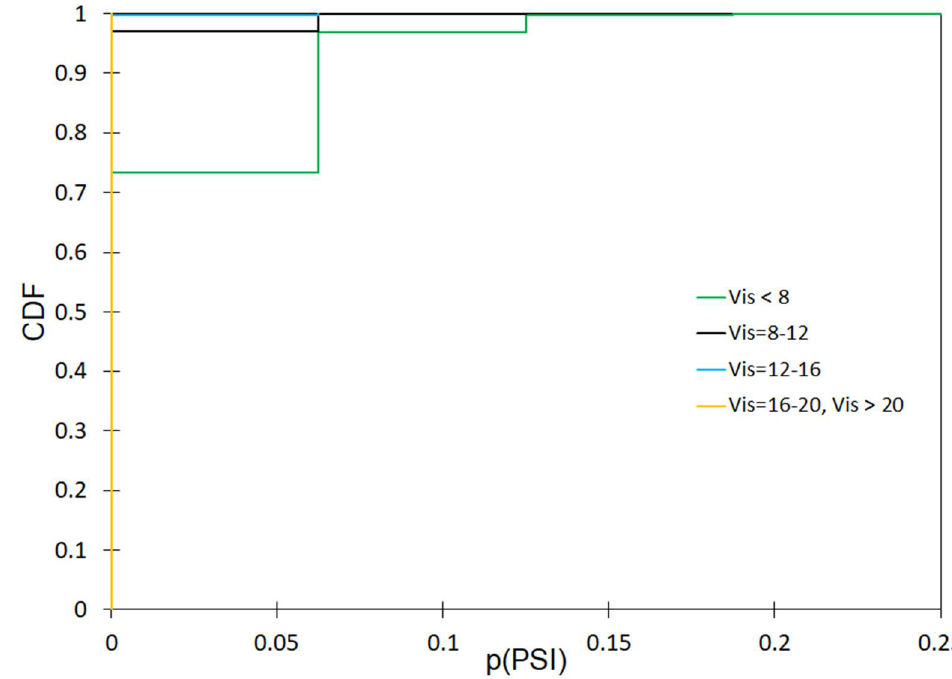
Figure A30. Effect of visibility on the incidence of high winter mortality for rainy days.